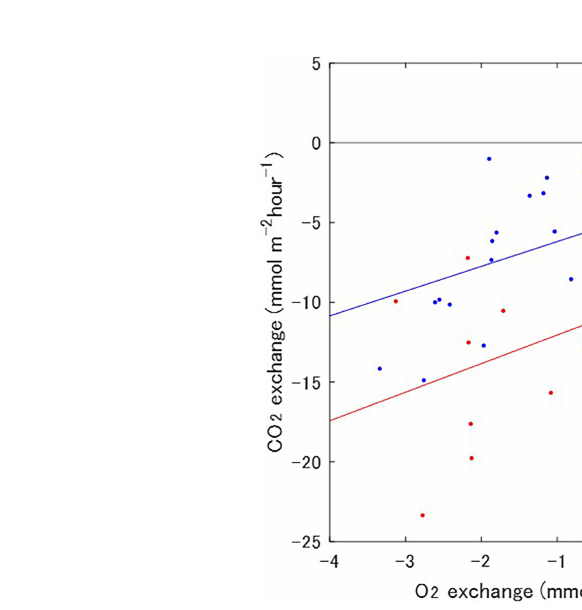
FIGURE 4 Comparison between atmospheric CO 2 and O 2 exchange rates. The red and blue dots indicate exchange rates during daytime and nighttime, respectively. The red and blue lines are the linear regressions between the two rates during the daytime ( R 2 = 0.44, p = 0.03) and nighttime data ( R 2 = 0.47, p =